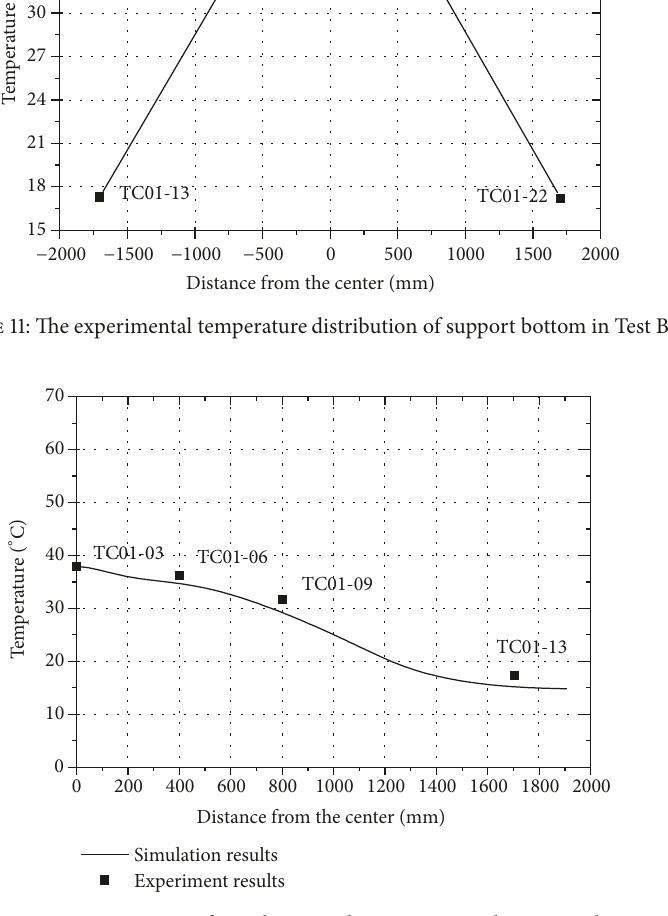
∘ ∘ C to 30 C, the maximum temperature